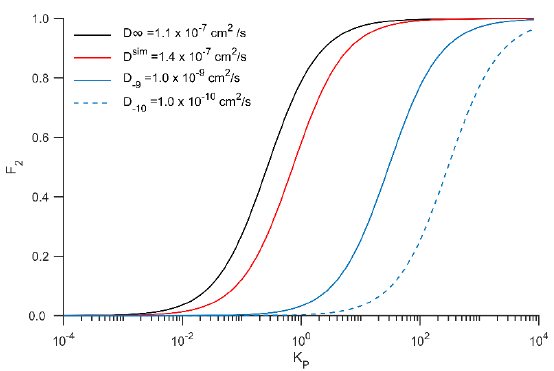
Figure 8. Fraction of binding from membrane bound toxin with respect to the total binding rate (F 2 ) as function of the partition coefficient (K p ) for different diffusion coefficients along the membrane. Calculations were carried out with equation 4 assuming R a = 0.5 nm and SA:V = 1 × 10 6 cm −1 .